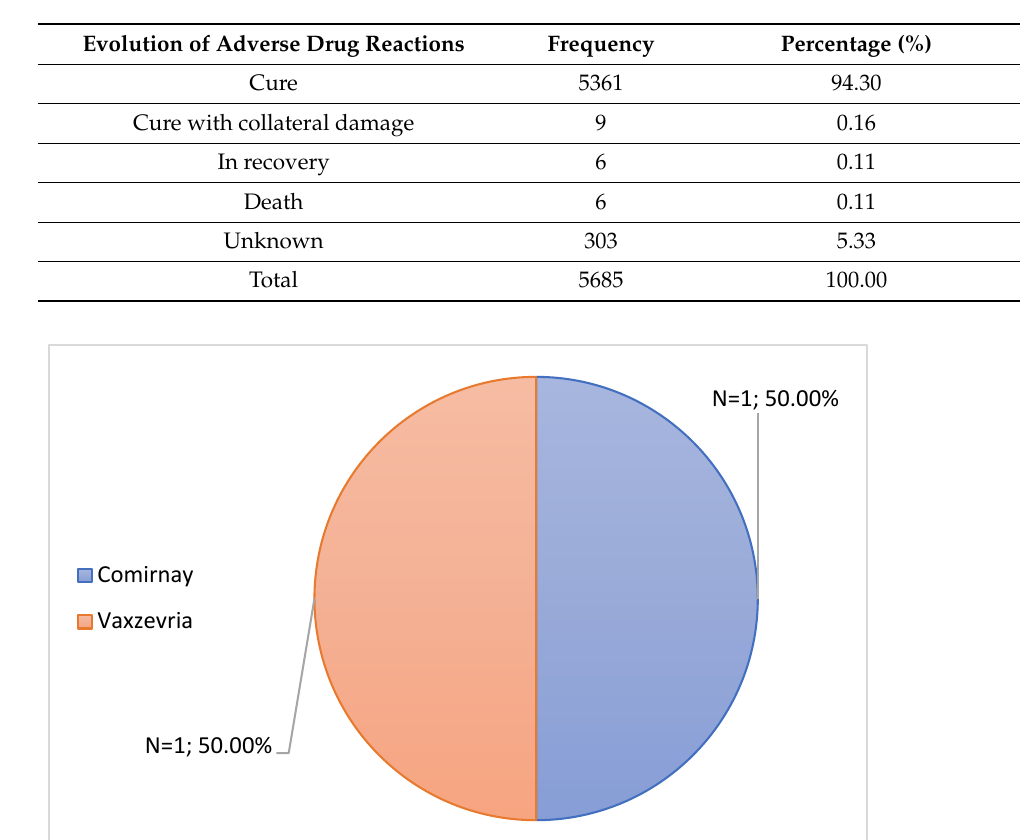
Figure 13. Characterization of serious notifications with the seriousness criteria “Death”, according to the brand of vaccine administered.